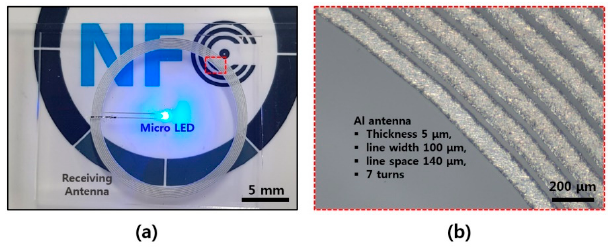
Figure 2. Images of fabricated soft optogenetic devices. ( a ) Photograph of wirelessly operated optoelectronic device on near-field communication (NFC) reader; ( b ) microscopic image of laser-cut aluminum (Al)